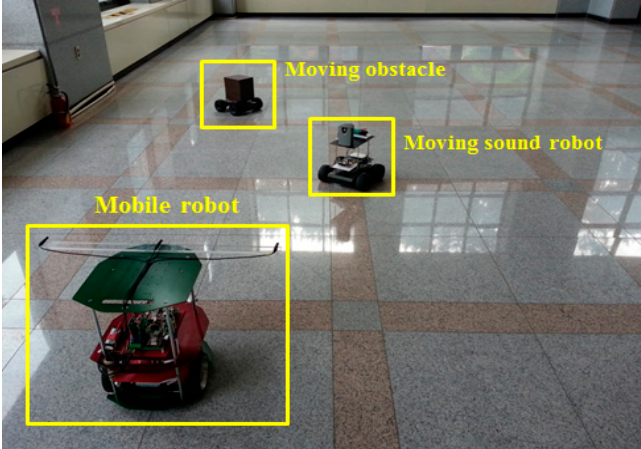
Figure 14. Experimental environment for moving obstacle avoidance. The size of the moving obstacle was 80 (W) × 30 (H) × 50 (D) mm.